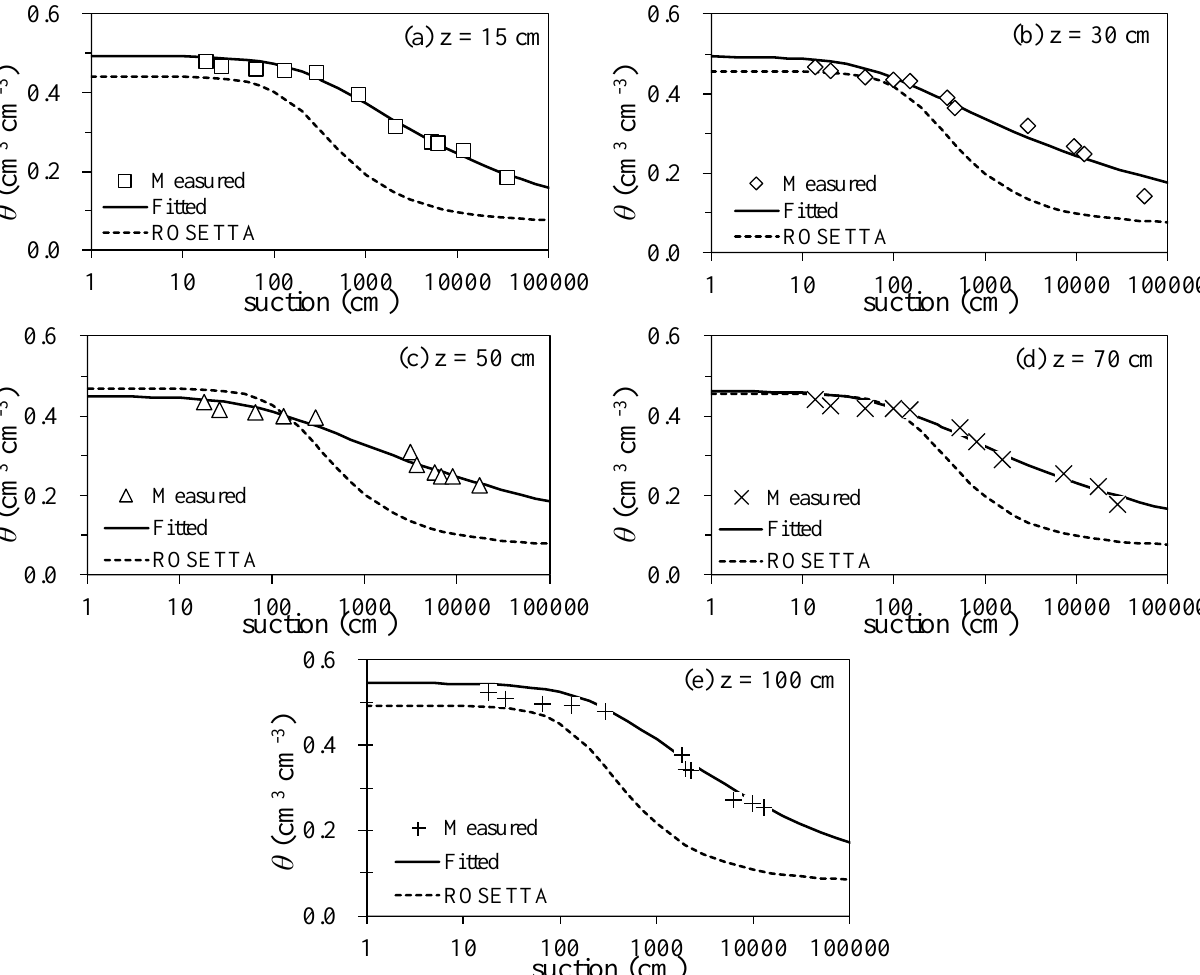
Figure 4. Soil water retention curves from measured data and as estimated by ROSETTA.